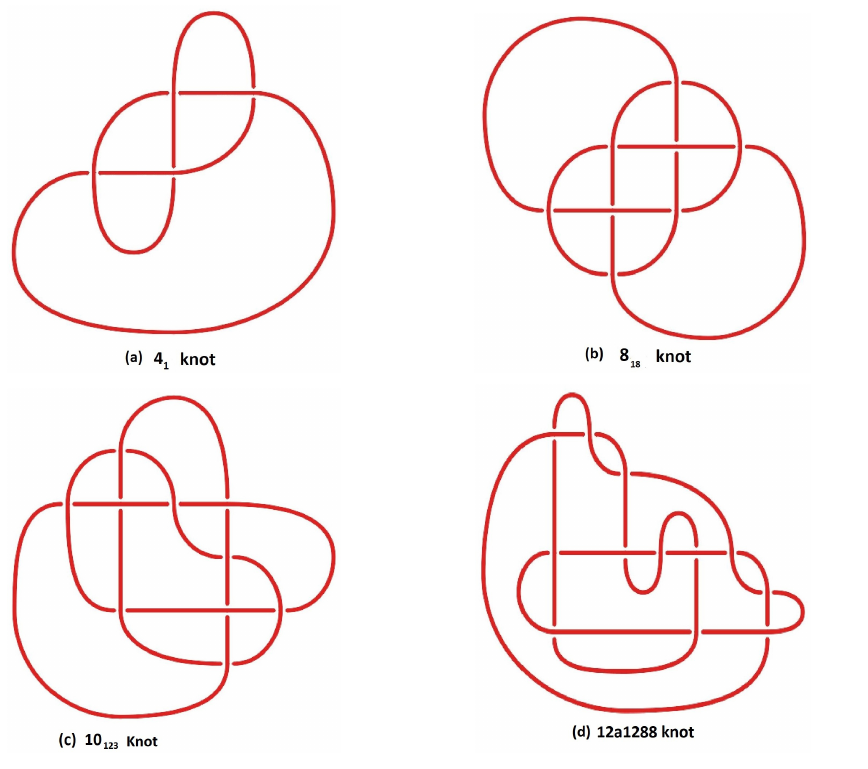
Figure 2 . Snappy diagram representation for hybrid knots [29, 30]: (a) ˆ W 3 (2 , 1) = 4 1 , (b) ˆ W ˆ W 3 (4 , 1) = 8 18 knot, (c) 3 (5 , 1) = 10 123 knot, and (d)